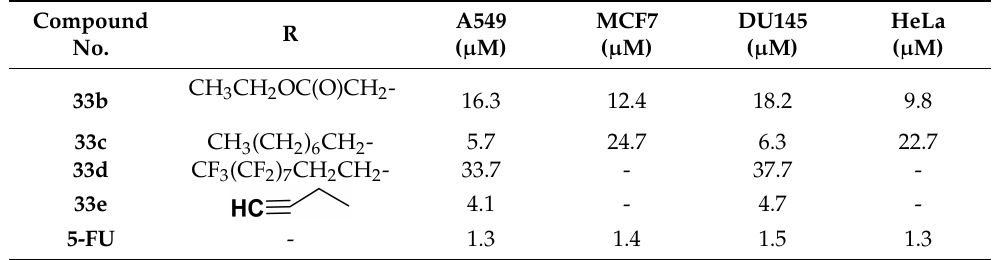
Table 26. In vitro cytotoxic activities of pyrimidine ‐ pyrazole based hybrid compounds 33 ( b – e ). Compound